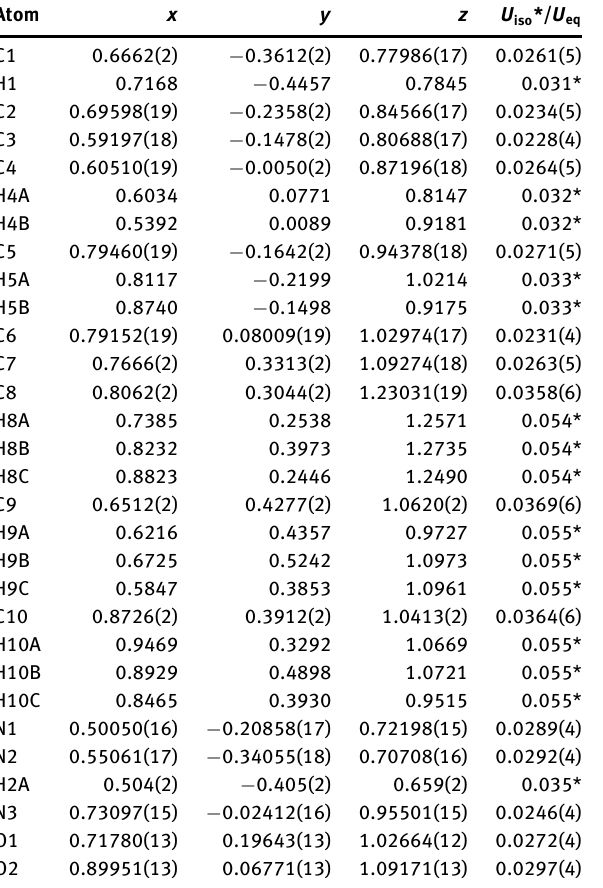
Table 2: Fractional atomic coordinates and isotropic or equivalent isotropic displacement parameters (Å 2